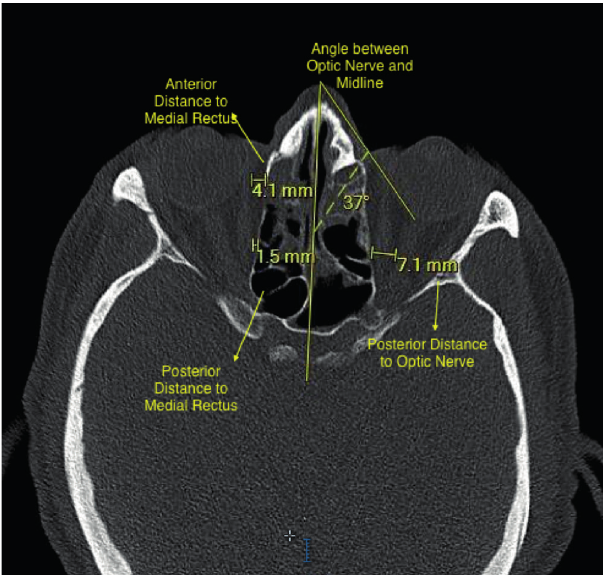
Figure 1. Axial CT measurements of the distance from the lamina papy- racea to various orbital structures and the angle between optic nerve and the nasal